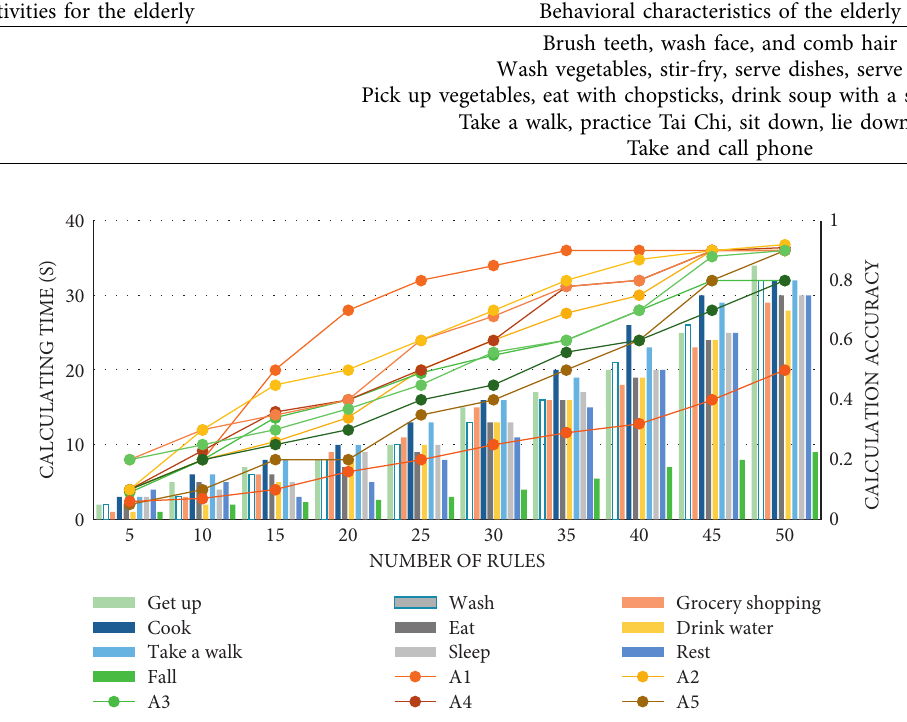
Figure 4: Performance of service demand reasoning algorithm based on rule pruning.